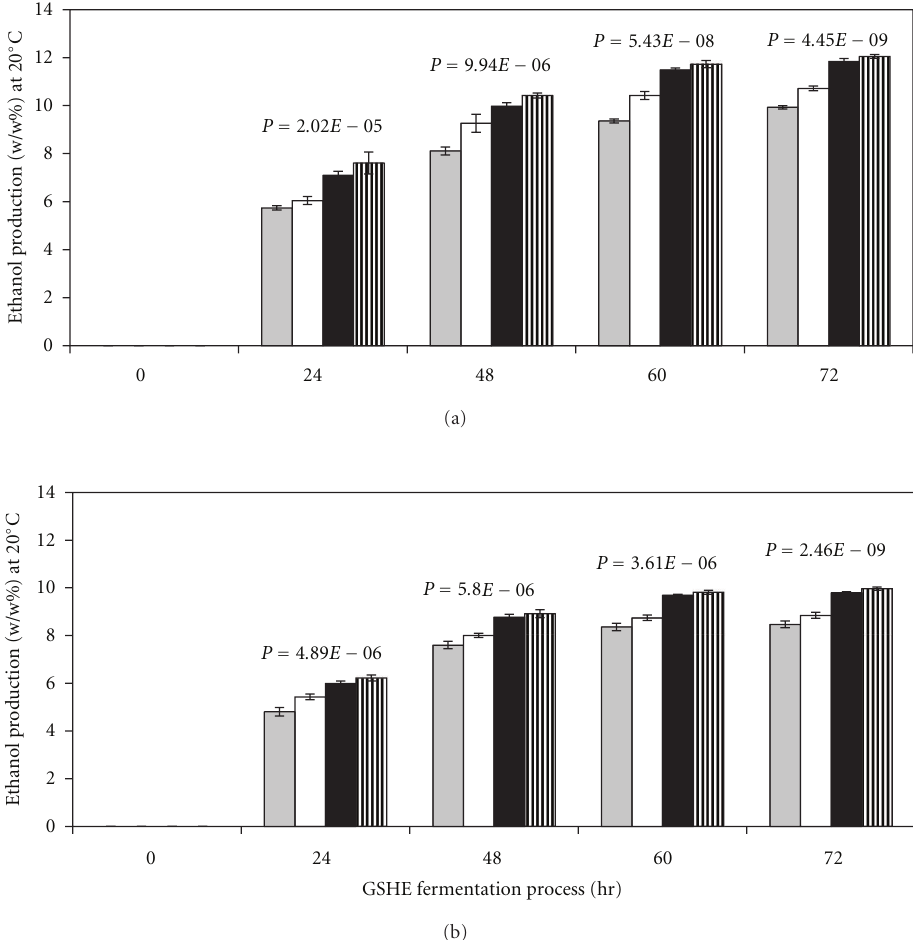
Figure 1: Ethanol yield (based on CO 2 release) profile of GSHE, under yeast fermentation process at 32 ± 2 ◦ C at various GSHE dosage (kg/MT of grain): 1.5 (grey); 2.0 (white); 2.5 (black); 3.0 (striped) when (a) Indian broken rice; (b) Indian pearl millet was used as a raw material. The values represent means ± S.D. of three experimental studies. The P value represents between all GSHE dosages at 24hrs intervals. P -value was found 0.04, 0.03, 0.18, and 0.22 in case of Indian broken rice at 24, 48, 60, and 72hr, respectively, while performing ANOVA of 0.25 and 0.3 kg GSHE dosage, whereas in case of pearl millet, P -value was found 0.03, 0.02, 0.29, and 0.35 at 24, 48, 60, and 72 hr,